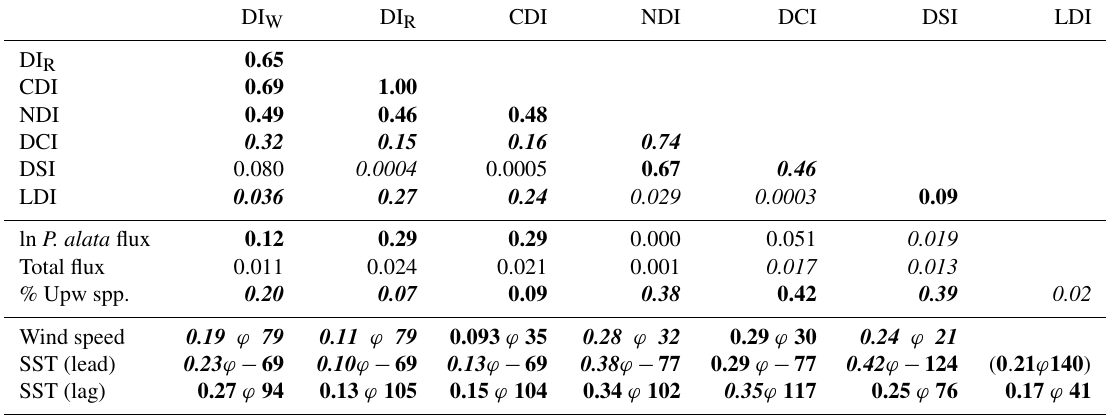
Table 4. Correlations ( r 2 ) between diol proxies and